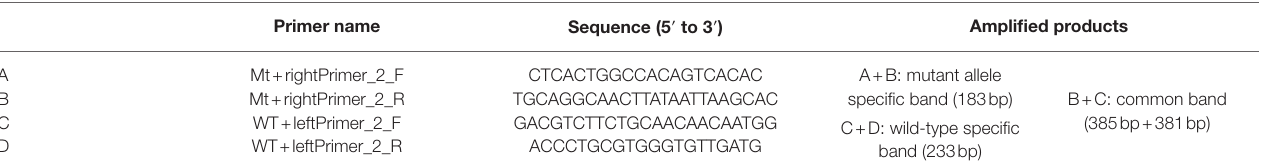
TABLE 2 | Primer sequences and products of one-step indel genotyping